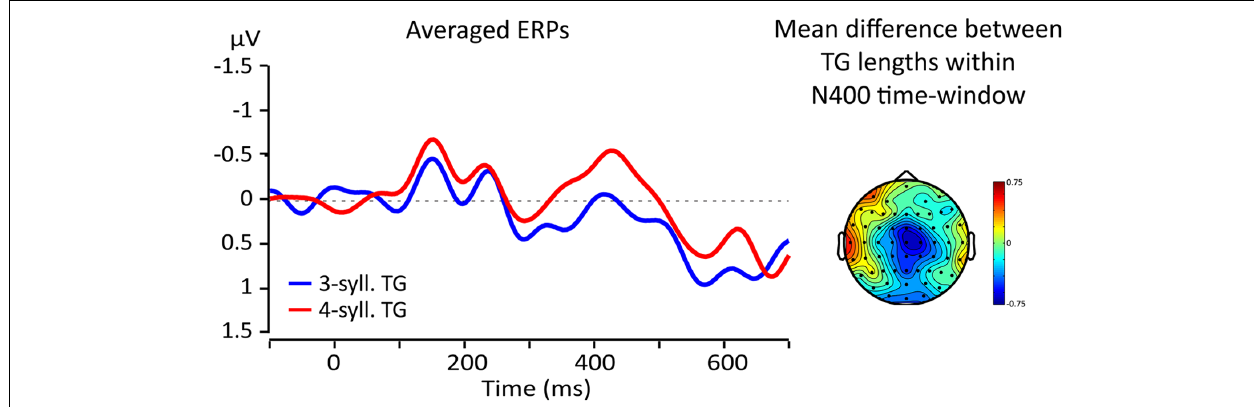
FIGURE 5 | Left: averaged responses for the fronto-central ROI; blue lines = 3-syllTG, red lines = 4-syllTG. Right: topography of the average differences between ERPs for targets fromTGs of different lengths (four- minus three-syll.) in the 350–450 ms time-window.